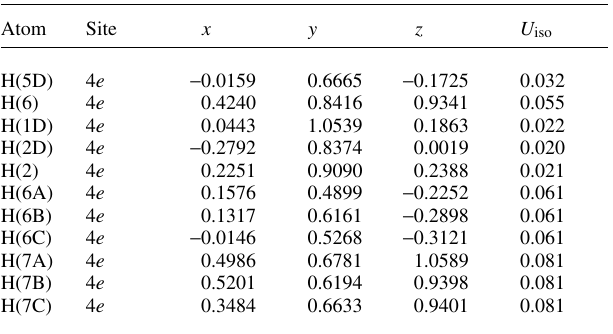
Table 2. Atomic coordinates and displacement parameters (in Å 2 ) .